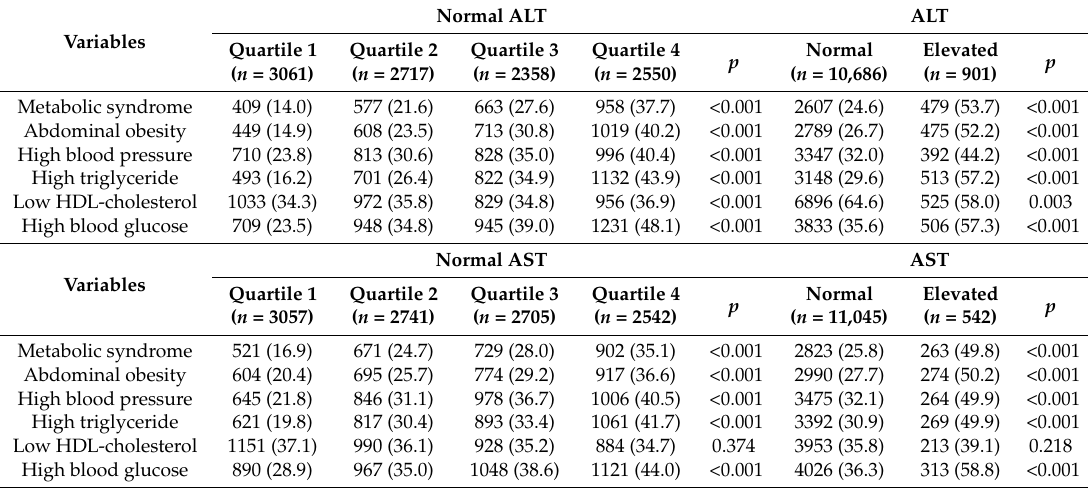
Table 2. The prevalence of metabolic syndrome and its components according to the liver enzyme.